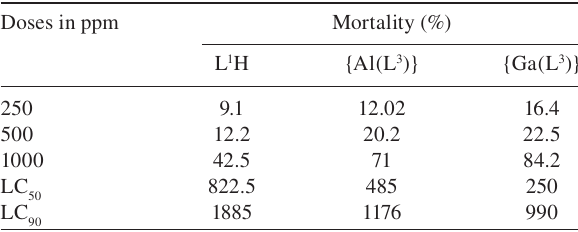
Table 6 Toxicity of ligand L 1 H and its metal complexes against adult females of C. trachypterus (Blanchard).